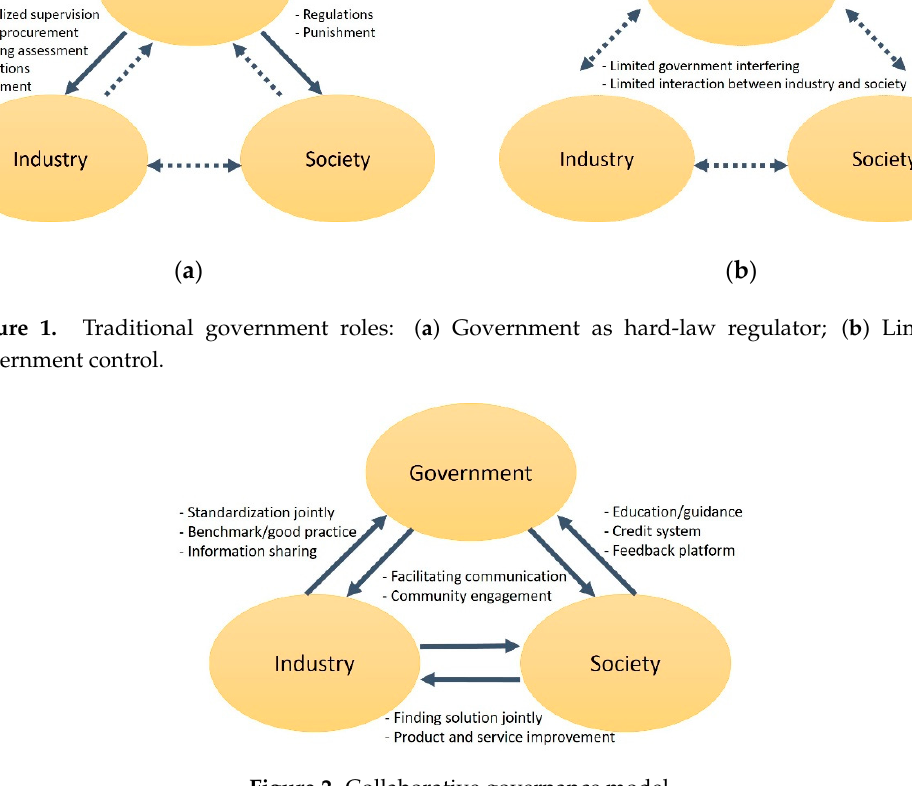
Figure 2. Collaborative governance model.